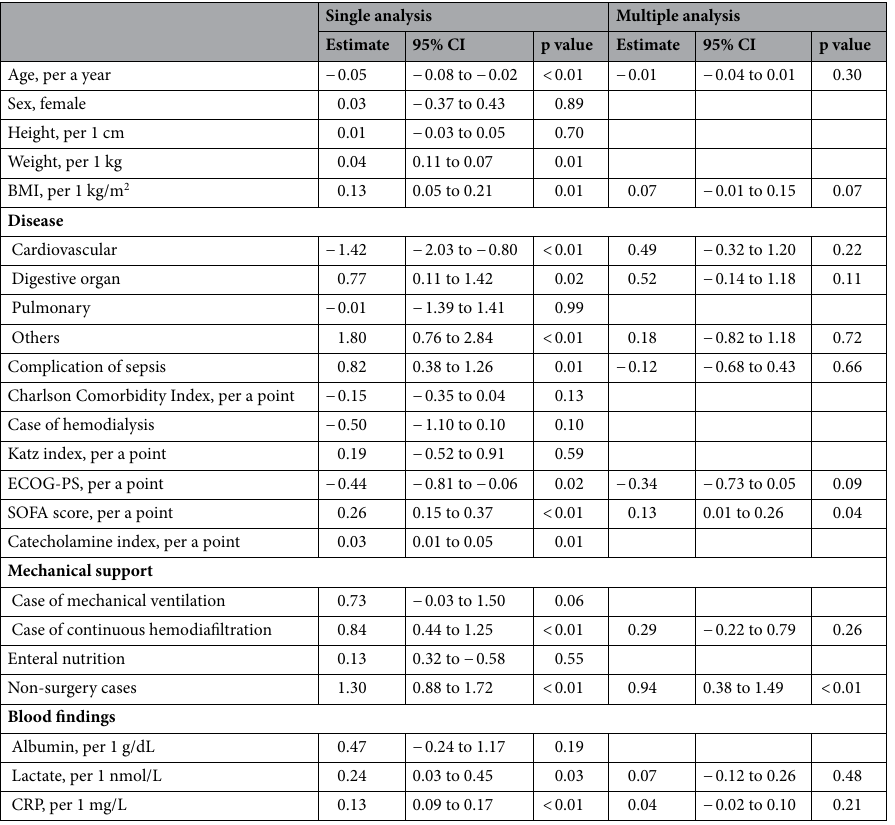
overall and sensitivity, 0.71; specificity, 0.82 in surgical cases).